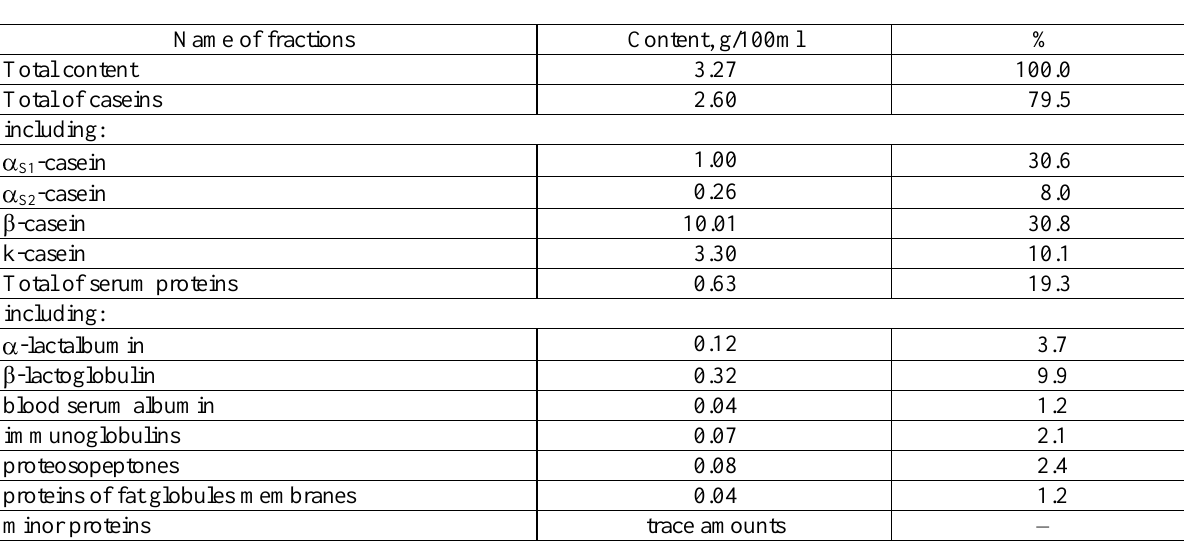
Table 2. Main groups of albumins of raw milk